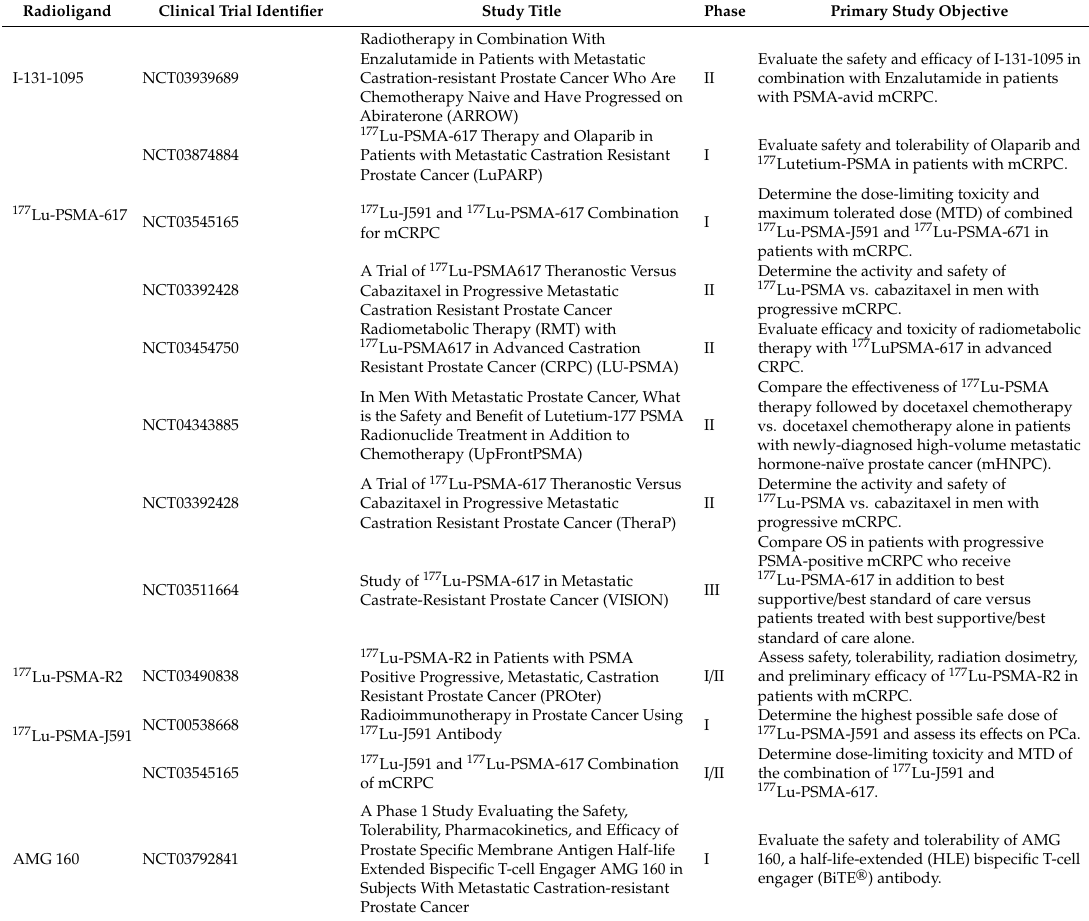
Table 2. Ongoing clinical trials of PSMA RLT with enrolment of at least 50